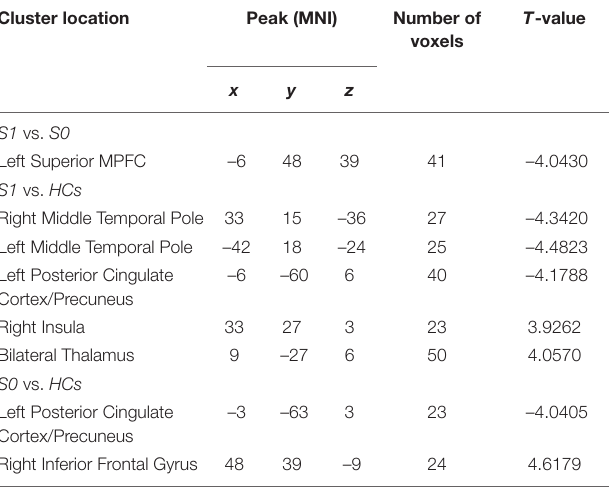
TABLE 2 | Significant GFC differences across